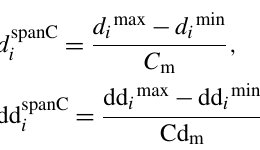
Figure 3. BME680 resistance data for the period from 8 July to 11/19 September for temperature steps from 50 to 400 ◦ C as well as the scaled-up Varroa count